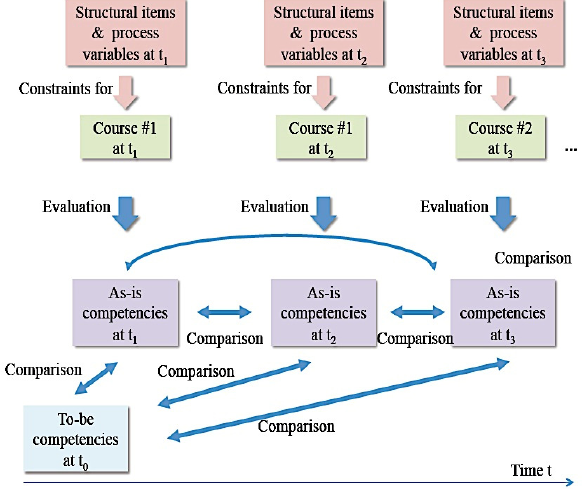
Figure 1. Structure of our research